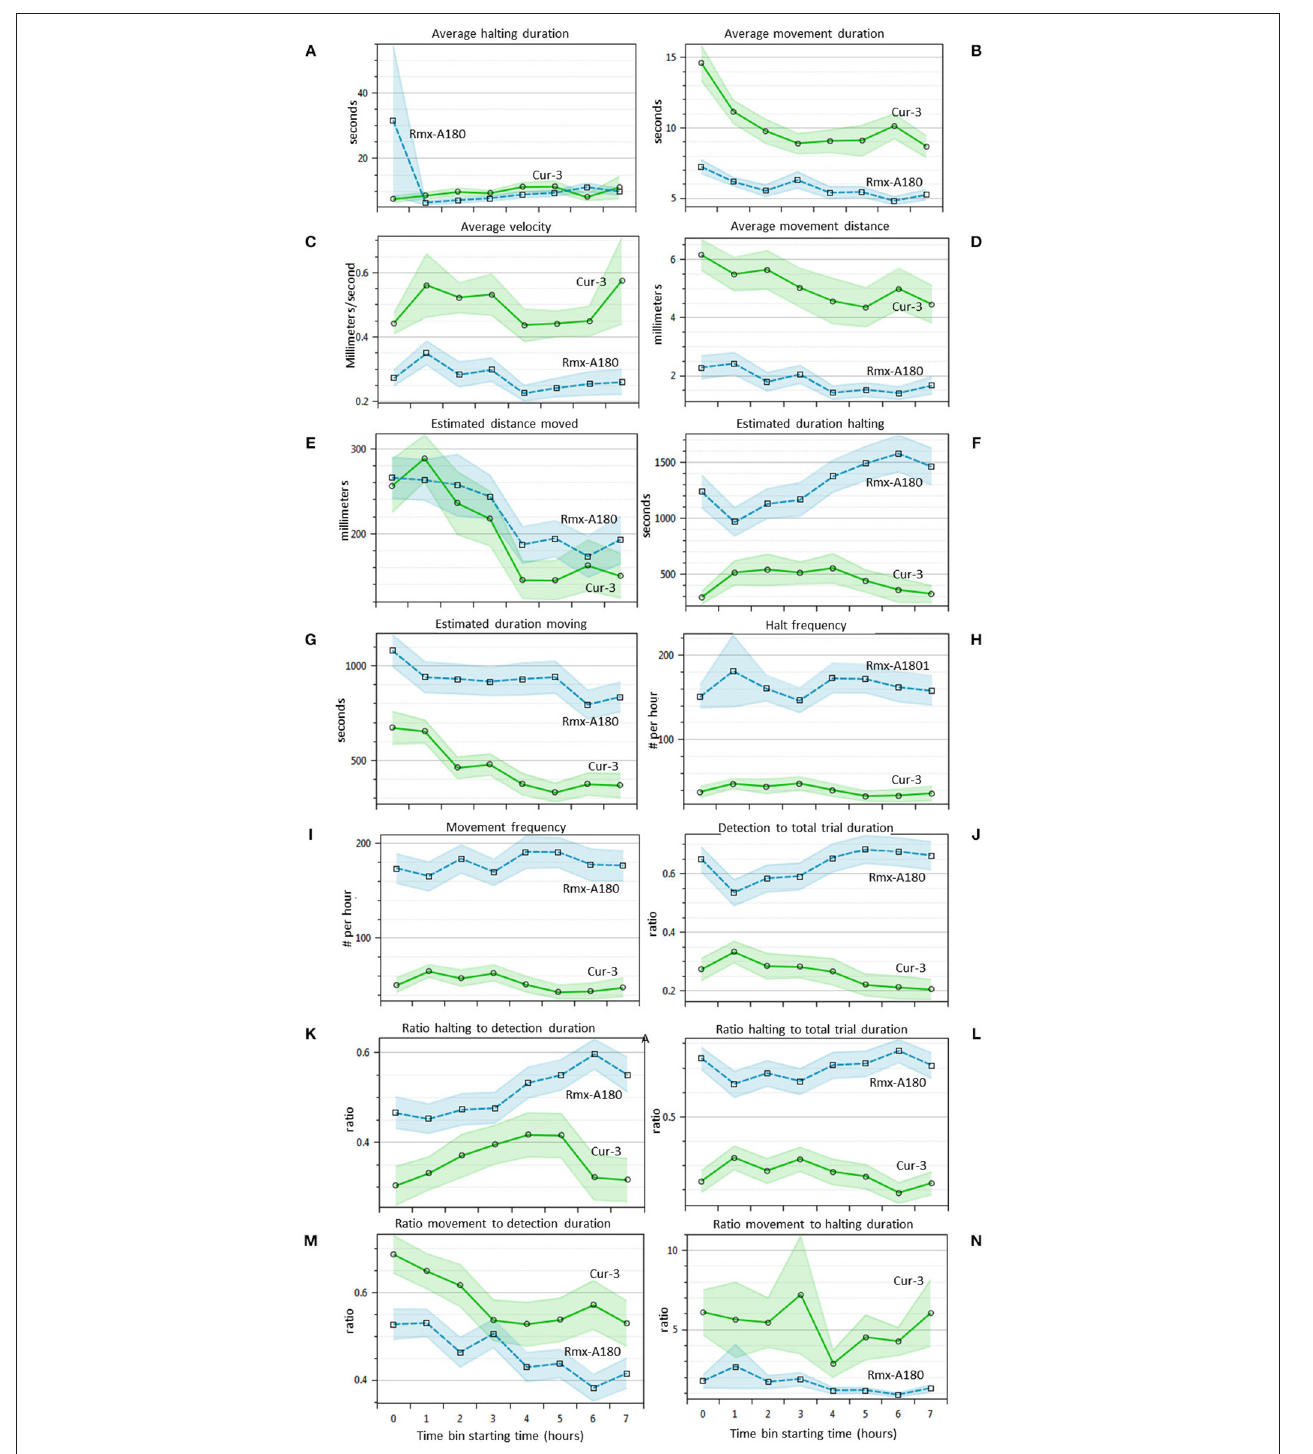
FIGURE 4 | Thrips choice behavior statistics in time (A–N) . Overview of 14 different statistics that are automatically indexed per hour by EthoAnalysis. The 95% confidence intervals are indicated by blue and green shading (excluding effects of experimental design). The results are given for experiment 3 (analysis F1) and are based on 39 arenas. Estimated values are per hour, corrected for the percentage detection (except frequency), and log-transformed for averaging. The average detection level was ∼ 90% in this experiment.